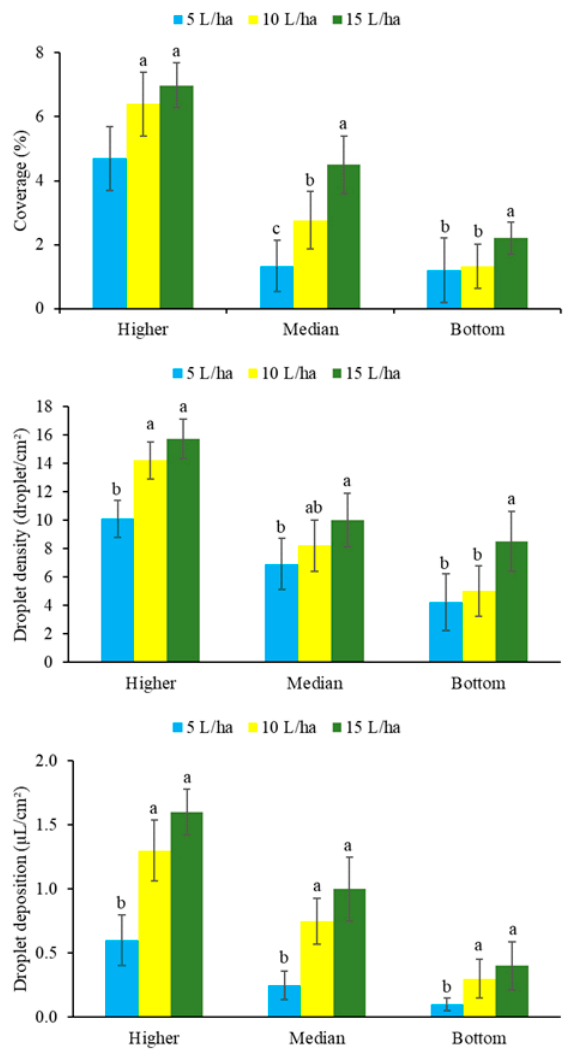
Figure 7. Droplet distribution in coffee layers using different application rates. Bars represent the treatments: T1, T2, T3, T4, T5, T6, T7, T8, and T9, from left to right. Means followed by the same lowercase letter between layers do not differ at 0.05 level of significance by Tukey’s test. The target coverage presented significant differences between treatments with the application rates of 15 L ha − 1 (T3, T6, and T9) and 5 L ha − 1 (T1, T4, and T7). When using 15